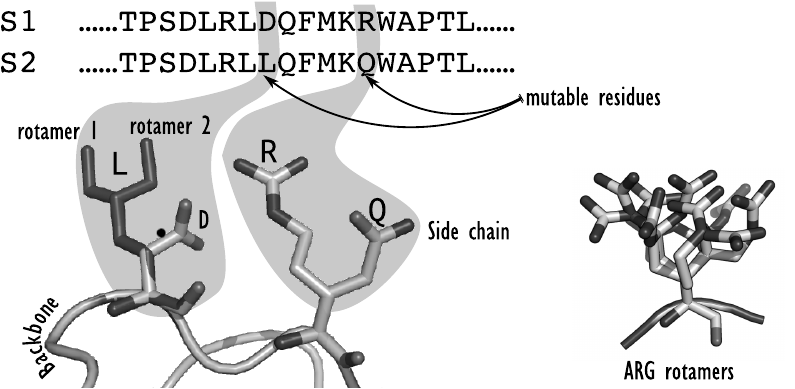
Figure 1. An example of two protein sequences (top) where two mutable amino acids have been redesigned. At the first position, the amino acid D (an aspartic acid) has been changed to a L (leucine), in a specific conformation (orientation). At the second position, the arginine R, with its very long and flexible sidechain has been changed to a glutamine Q. The figure on the right illustrates the potential flexibility of the long arginine sidechain, showing a sample of several possible superimposed conformations, representing a fraction of all possible conformations for an arginine sidechain in existing rotamer